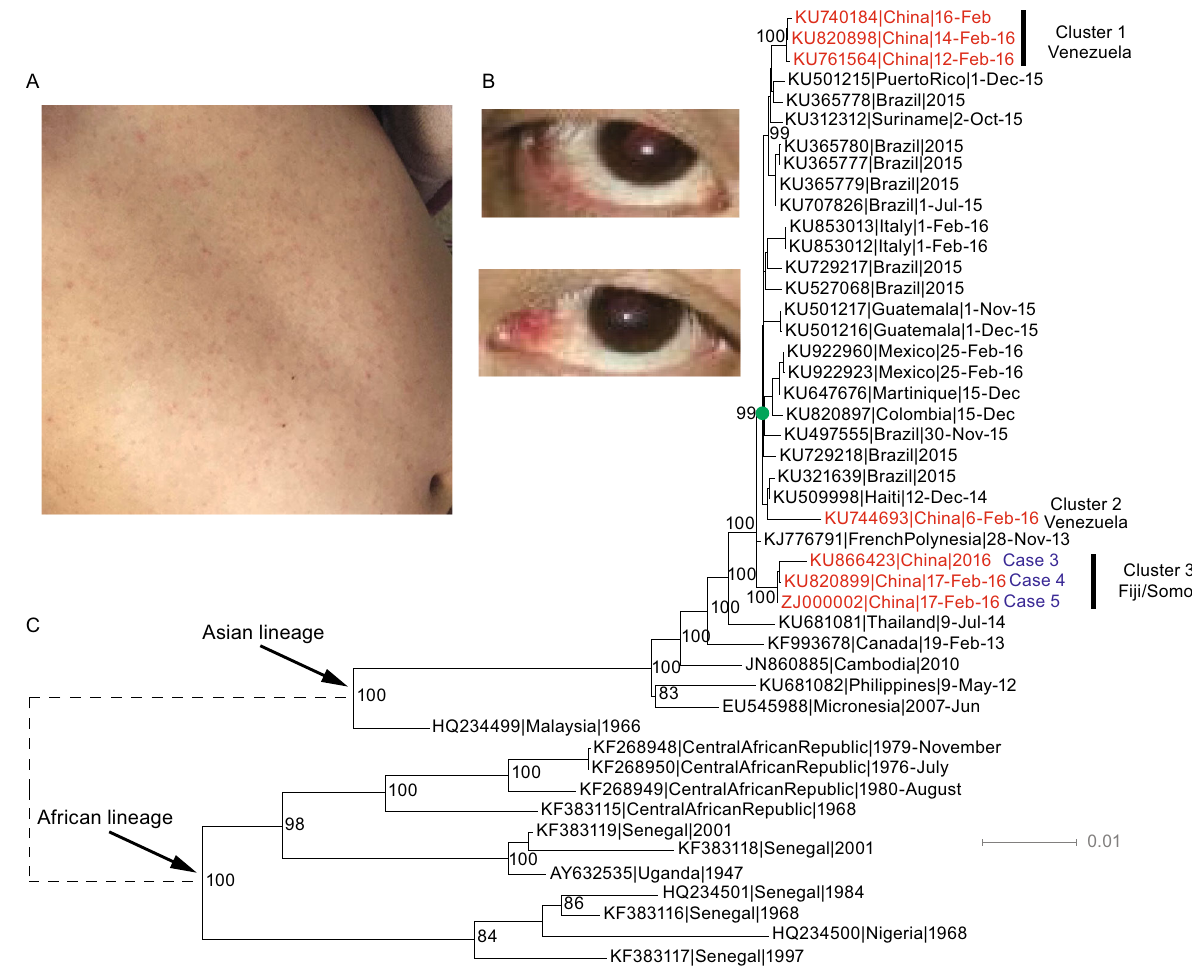
Figure 1. Symptoms of ZIKV disease and phylogenetic tree of full-length ZIKV genome sequences . (A) Rash and (B) conjunctivitis are readily observed in the patient. (C) The Maximum likelihood tree estimated using full-length ZIKV genome sequences. The seven available sequences from imported cases to China are highlighted in